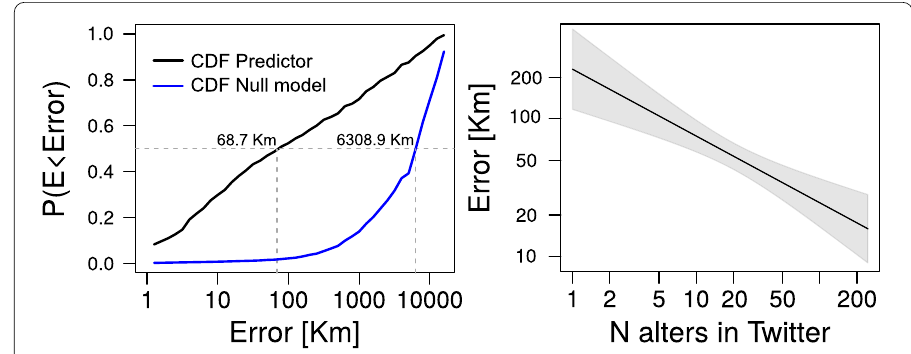
Figure 3 Location prediction quality using only disclosing alters. The left panel shows the Cumulative Density Function (CDF) of the prediction error of user locations when using only the data of disclosing alters. Black lines shows empirical errors and the blue line errors in the Null Model, revealing that empirical errors (median = 68.7 Km) are much lower than the Null Model errors (median = 6308.9 Km). The right panels shows the regression profile of the empirical error versus the number of disclosing alters in Twitter. The line shows the model estimate and the shaded area its standard error. Prediction error decreases with the number of disclosing alters in